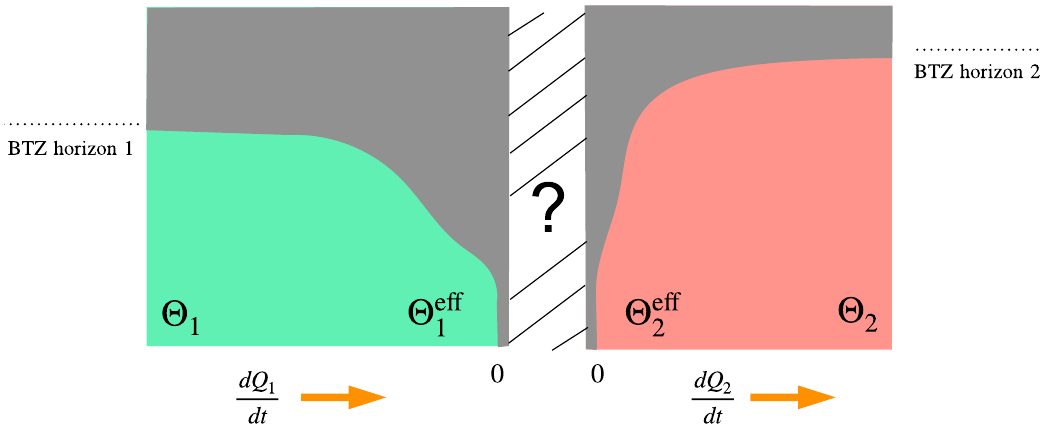
Figure 7 . A two-sided flowing funnel that can mimic the energy and entropy flows of the holo- graphic interface. Tuning the horizon temperatures so that the boundary black hole does not absorb any energy is, however, an adhoc